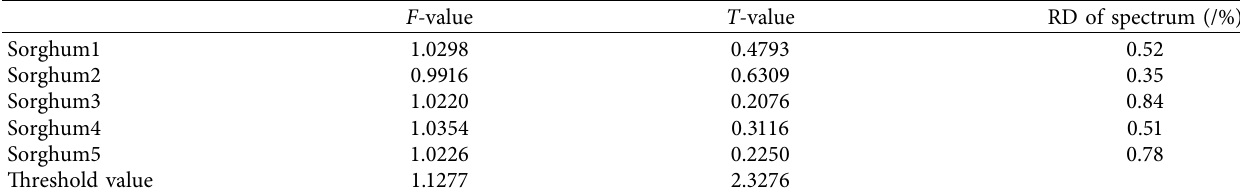
Table 7: RD of spectrum, F -value, and T -value of the actual mixed spectra and simulated mixed spectra of sorghum samples.